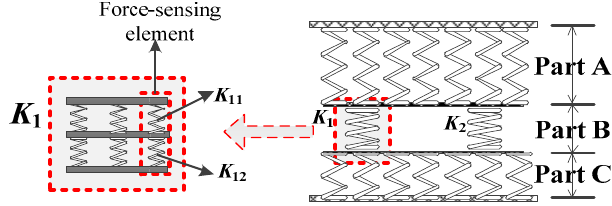
Figure 12. The equivalent spring model of the single force-sensing element.